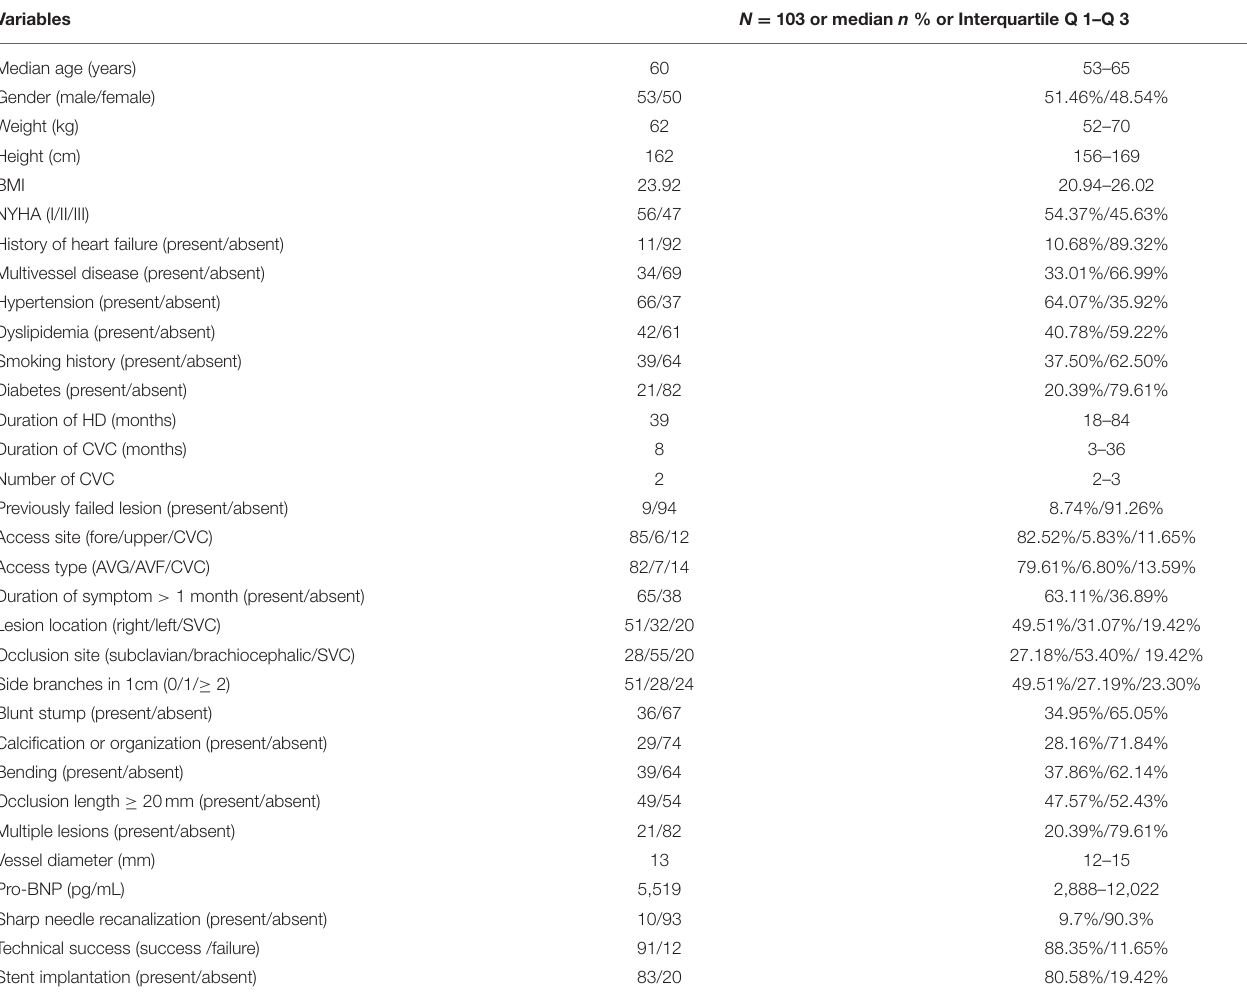
TABLE 1 | Demographic and clinical characteristics of patients in